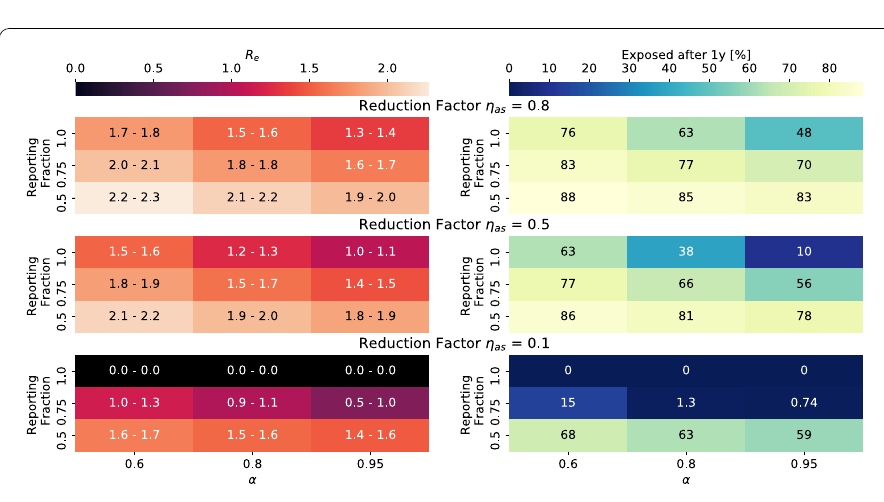
Figure 11 Outcomes when the contagiousness of a- and pre-symptomatic carriers, η as , is smaller than 1. Settings are R 0 = 3, p app = 0.6, η DCT = 1.0, trace uninfected contacts = false. The values printed for R e correspond to: (first number) the mean minus the standard deviation, and (second number) the mean plus the standard deviation, of the distribution of R e from 100 simulations (compare Fig. 6 bottom right panel), while the color of the field shows the mean. Where values are exactly 0.0, none of the 100 simulations had an outbreak (compare Sect.